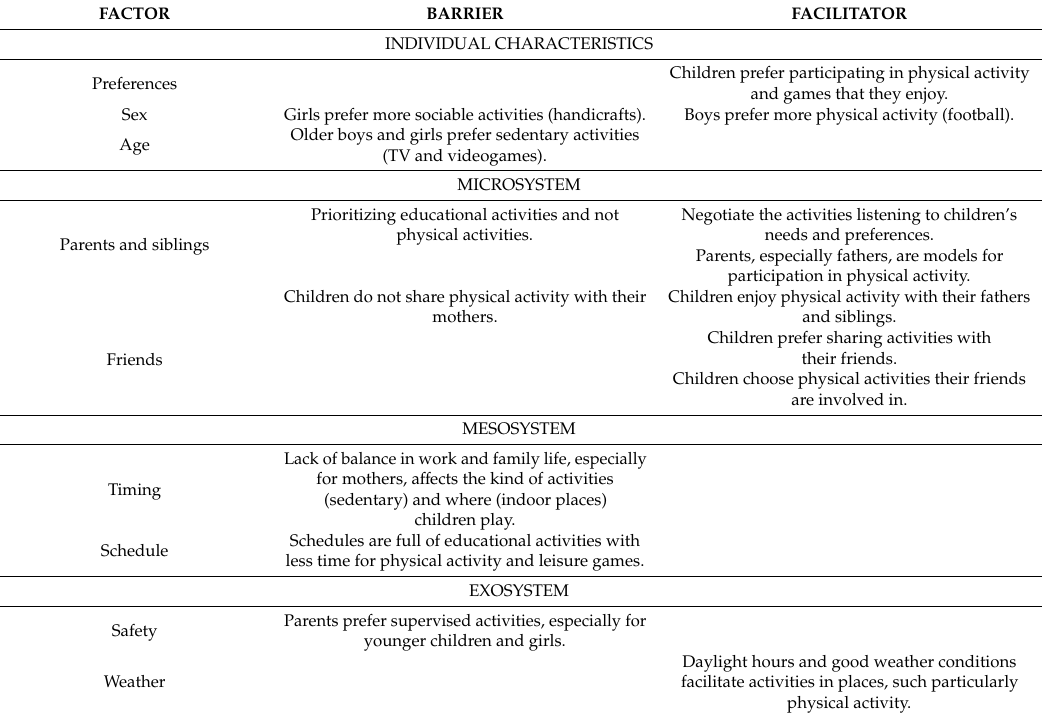
Table 3. Barriers and facilitators by level of Bronfenbrenner’s socio-ecological